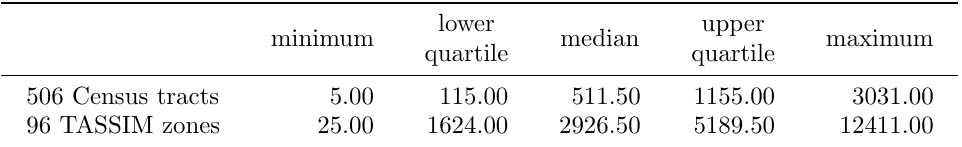
Table 1: Five-number summary of counts of owner-occupied one-family housing units by observational unit; observational units 506 Census tracts and 96 approximate TASSIM